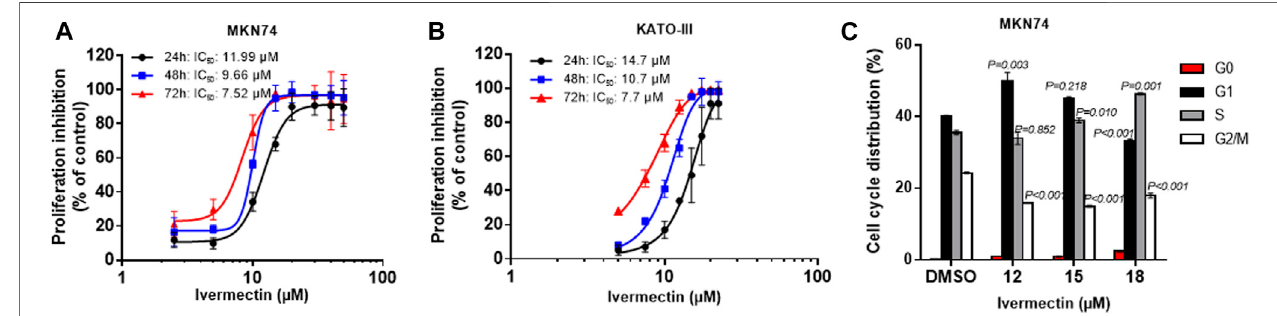
FIGURE 5 | Time- and concentration-dependent effects of ivermectin on proliferation and cell cycle. (A,B) Concentration-response curves upon 24 – 72 h ivermectin-treatment in MKN74 and KATO-III cells. Proliferation was assessed using CCK-8 Kit at 450 nm. IC 50 values were calculated from sigmoidal regression curve fi tting using variable slope on normalized response from log (cid:1) 3 10 -transformed x-values (GraphPad Prism v.6). (C) Cell cycle analysis of KATO-III cells. Means of n replicates/treatment with SD. One-way ANOVA with Dunnett ’ s post hoc test (2-sided) compared to respective control